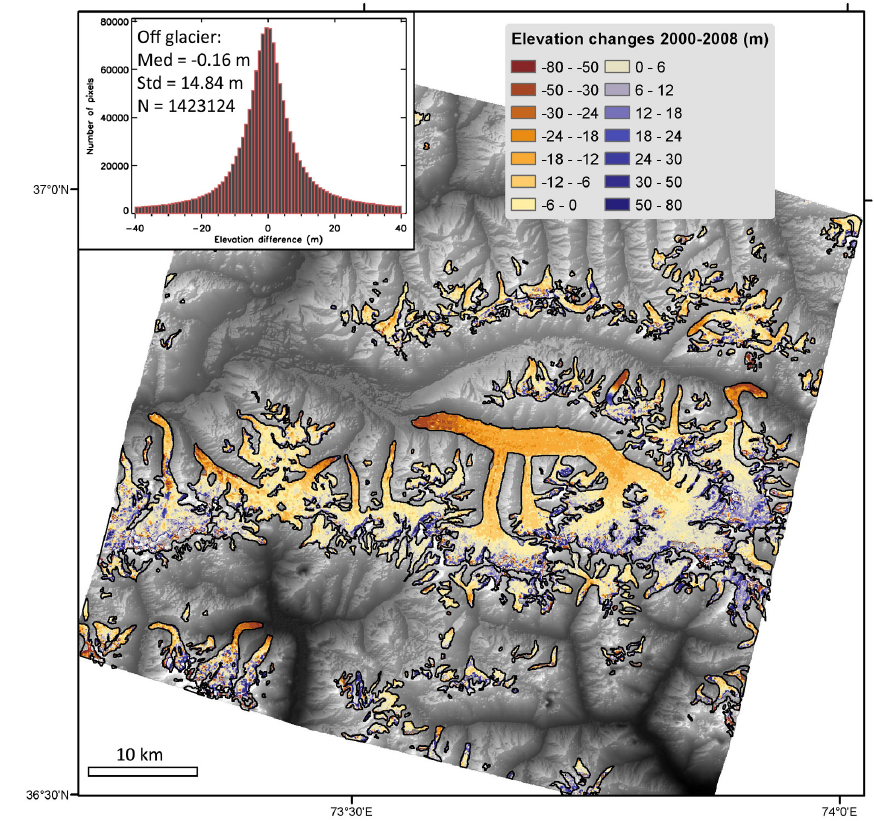
Fig. 7. Same as Fig. 2 but for the Hindu Kush study